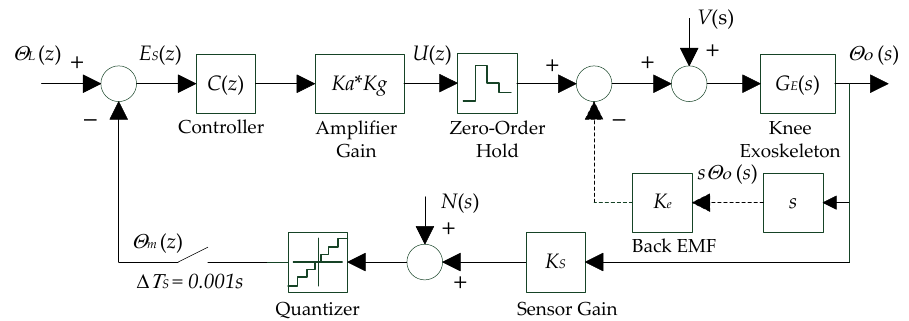
Figure 6. Block diagram of the inner-loop digital servo controller.